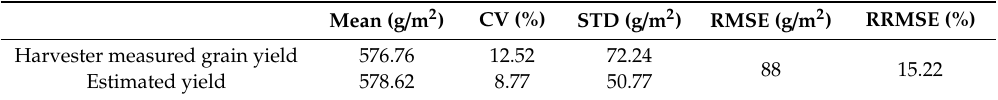
Table 4. The mean grain yield, coe ffi cient of variation (CV), and standard deviation (STD) of grain yield measured by harvester and estimated by SAFY model. The root mean square error and relative root mean square error between the harvester and estimated